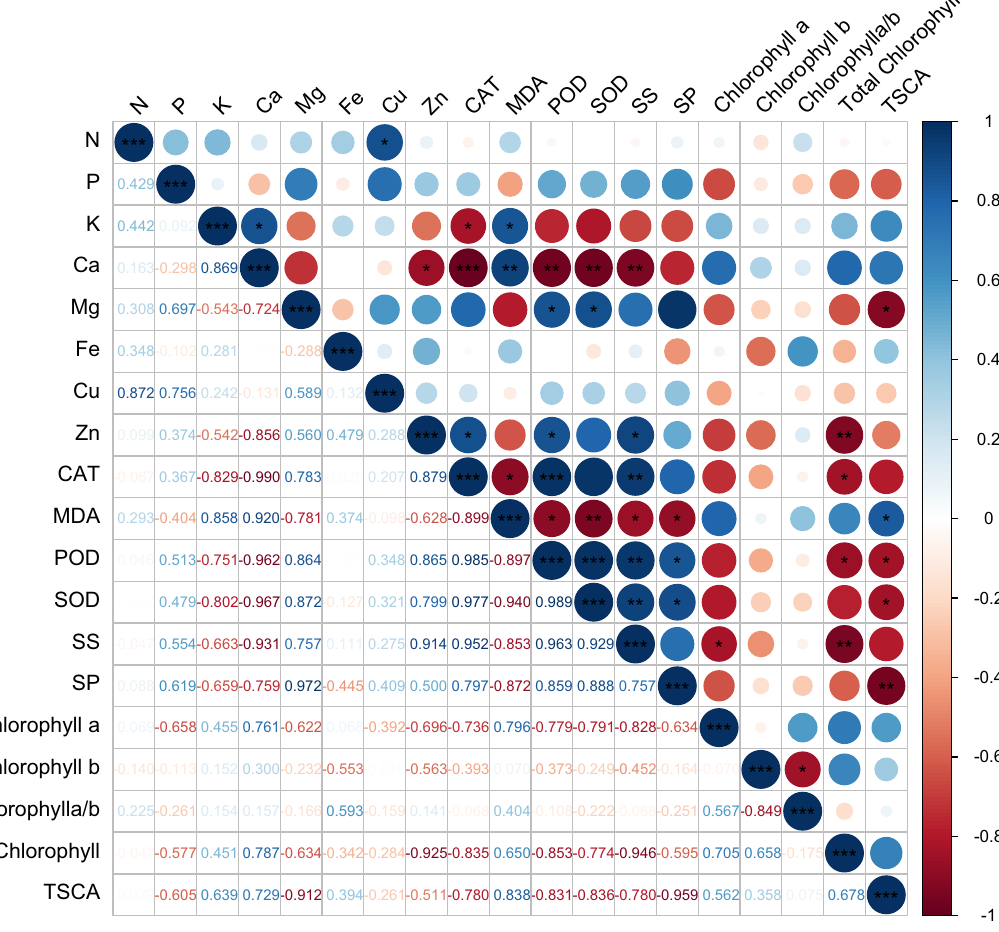
Figure 5. Correlation analysis heat map, SS and SP represent for soluble sugar and soluble